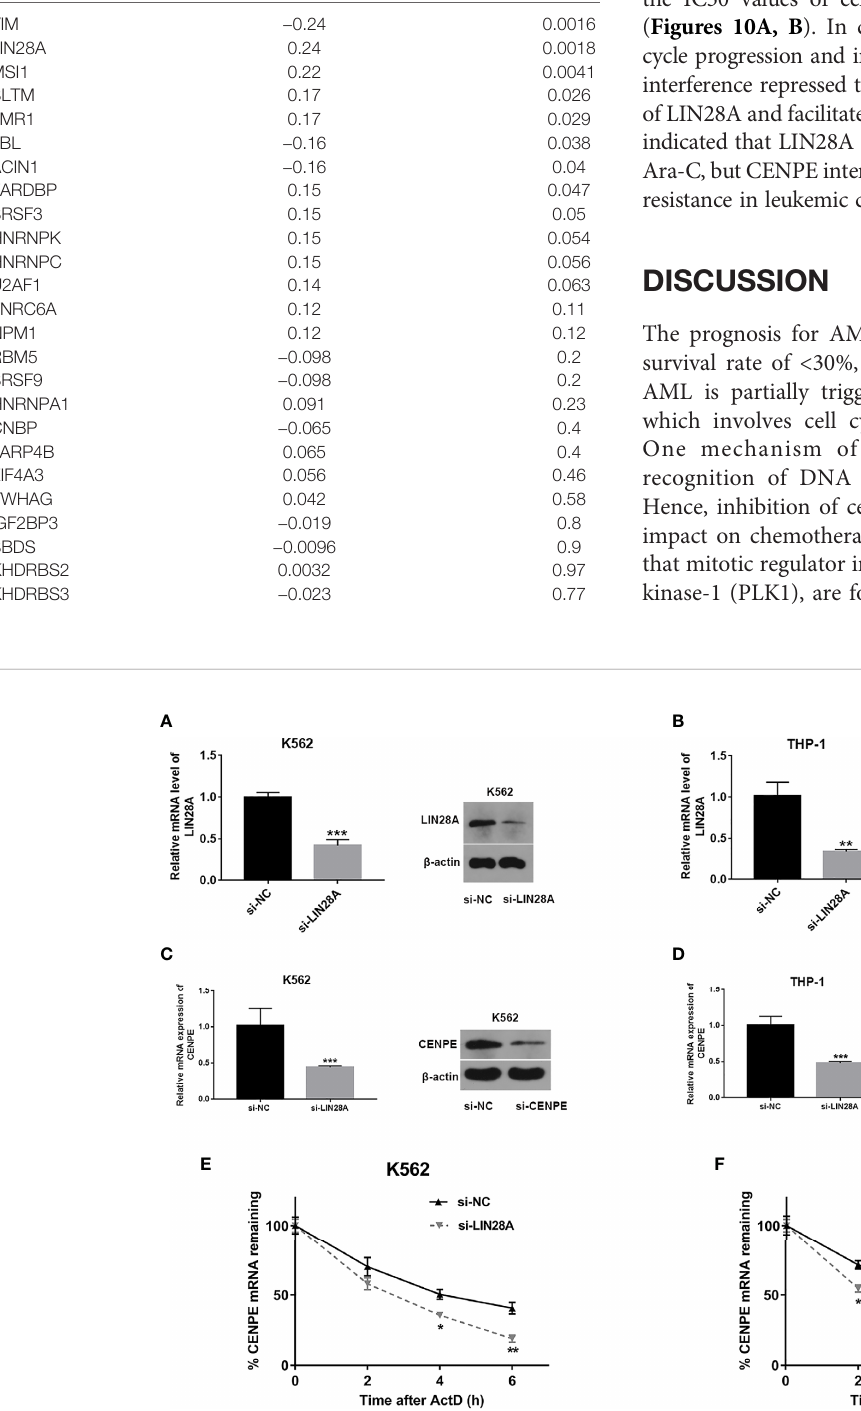
FIGURE 6 | LIN28A effected CENPE expression and mRNA stability. (A, B) Transfected K562 and THP-1 cells with si-NC or si-LIN28A, and LIN28A mRNA and protein were detected by RT-qPCR and Western blot 48 h after transfection. (C, D) Forty-eight hours after transfection of LIN28A in K562 and THP-1 cells, CENPE mRNA and protein were examined by RT-qPCR and Western blot. (E, F) The impact of the knockdown of LIN28A on the stability of CENPE mRNA was evaluated by the actinomycin D assay. * p < 0.05. ** p < 0.01. *** p <